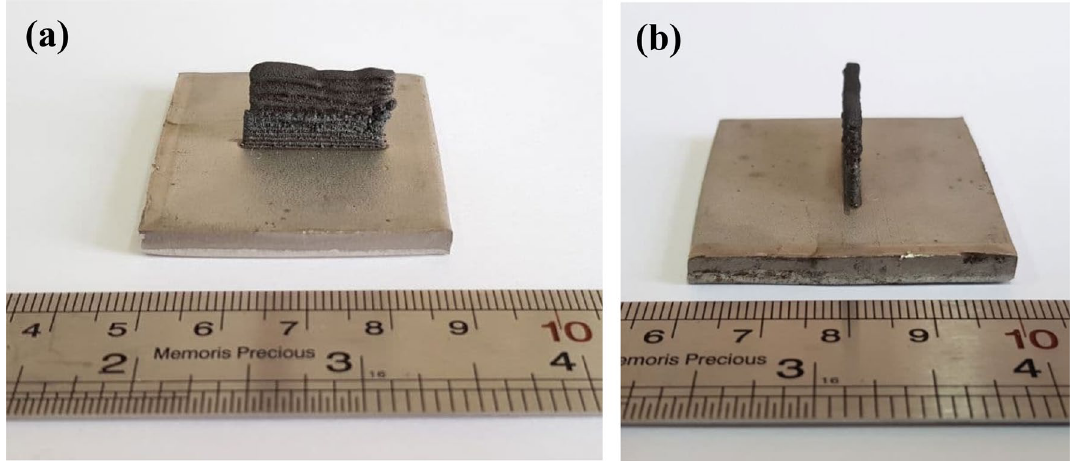
Figure 4. ( a ) Front view and ( b ) side view of the SS316L-IN718 multi-material structure fabricated according to Fig.